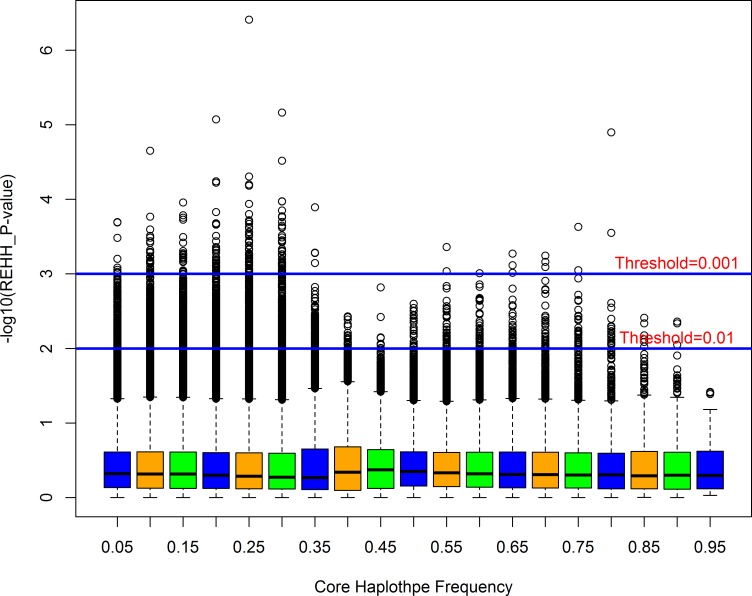
Box plot of the distribution of P-values in core haplotype frequency bins in the F2 population.The two continuous blue lines indicated the threshold P-values of 0.01 and 0.001, respectively.